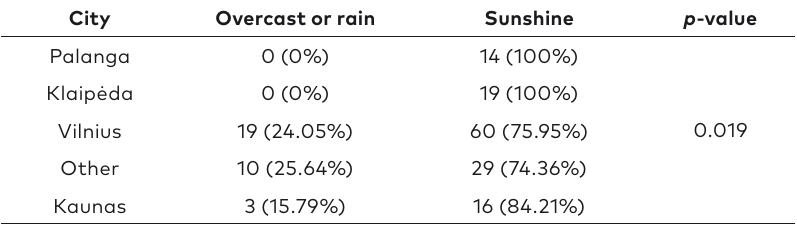
Table 6. The distribution of injuries by weather conditions and by city